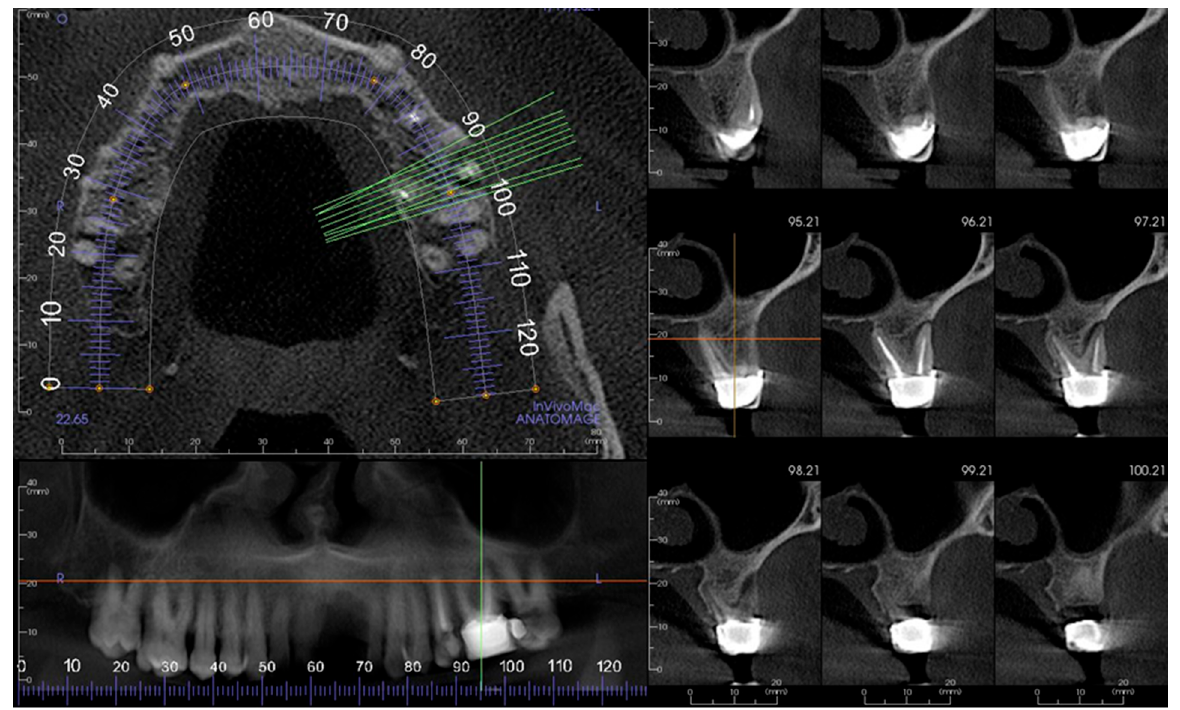
Figure 3. Apical disease present: no mucosal thickening. Mucosal thickening in a maxillary sinus was more likely if the neighboring tooth was associated with radiographic signs of apical disease (Figure 4).